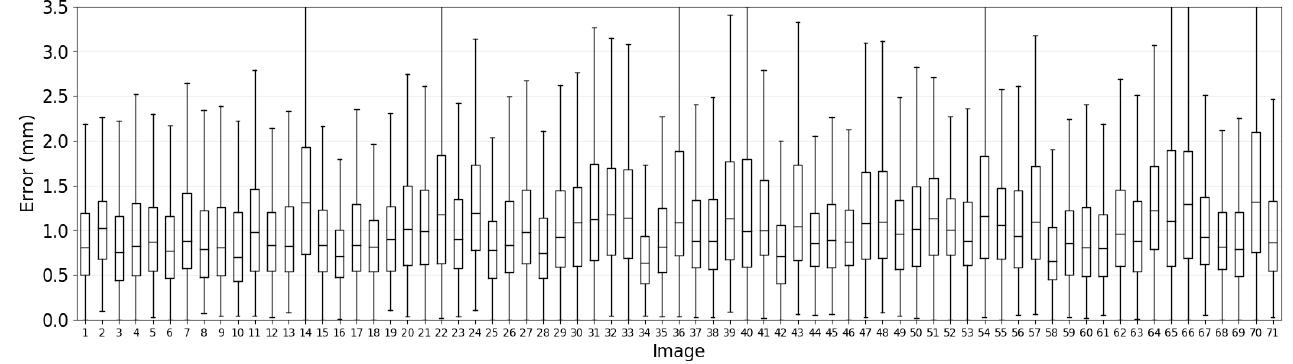
Figure 7. Box-and-whisker plots of errors by image for F.A., comparing each landmark to the centroid of the other annotators and taking the median across each image.